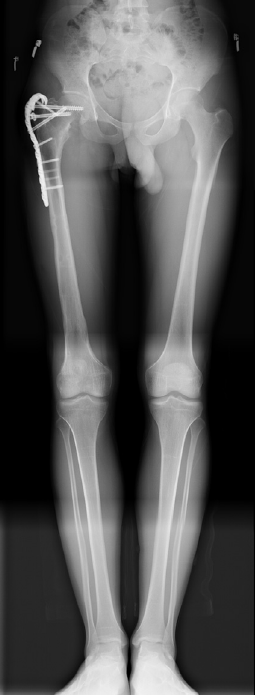
Figure 5. Same patient after the removal of external fixation (Case No. 5 in Table 1).